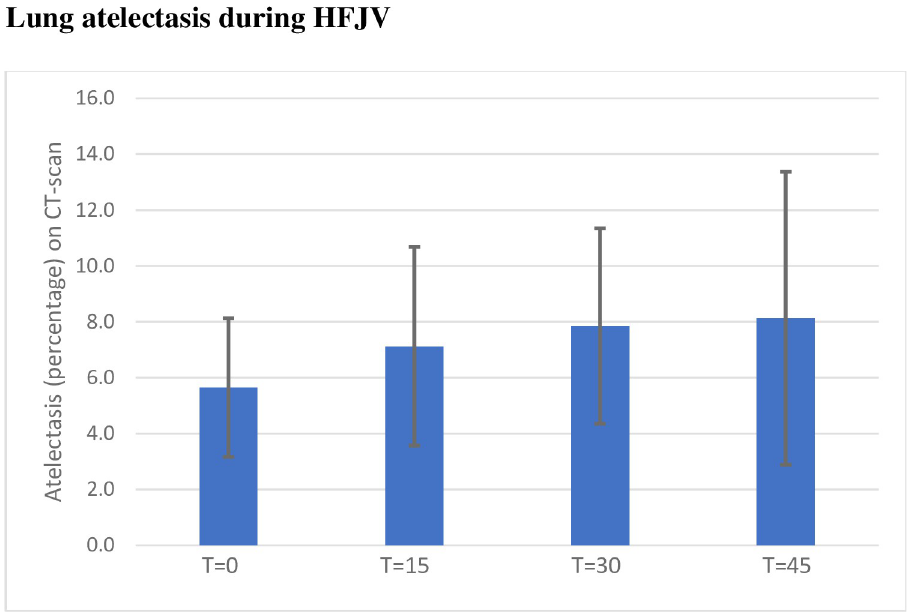
Fig 1. Mean atelectasis in percentage (HU -100-+100) and standard deviation bars. T = 0 being the first CT after initiation of HFJV (high frequency jet ventilation) and thereafter CT-scans every 15 minutes. A significant raise in the amount of atelectasis could be seen at timepoints T = 30 and T = 45 when compared to baseline.